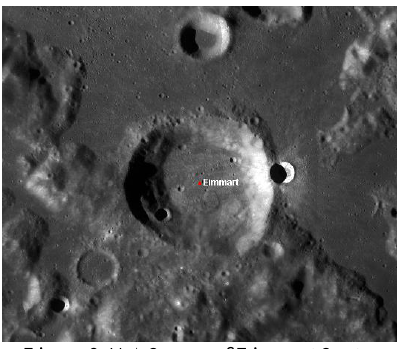
Figure 6. WAC map of Eimmart Crater